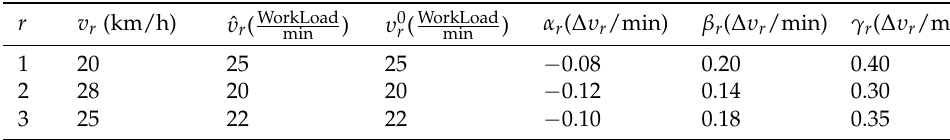
Table 3. Demand points information.